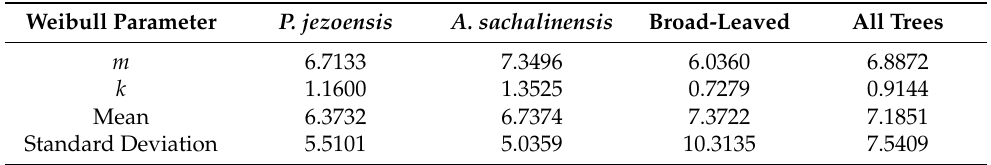
Table 4. Age-class probability Weibull distributions for major conifer species and broad-leaved trees.